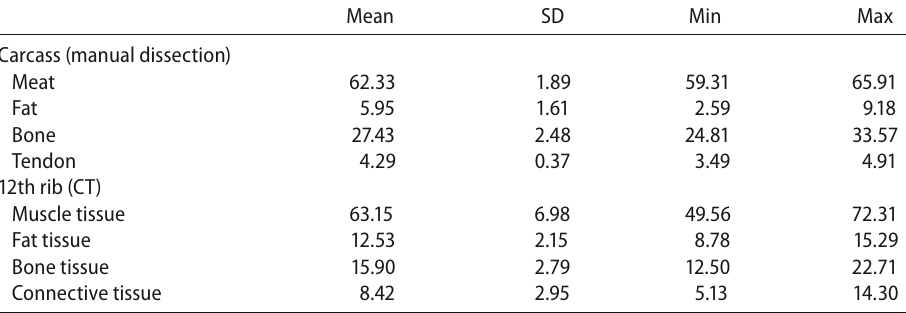
Dressing data (%) of buffalo male calves by two different methods Mean SD Min Max Carcass (manual dissection) Meat 62.33